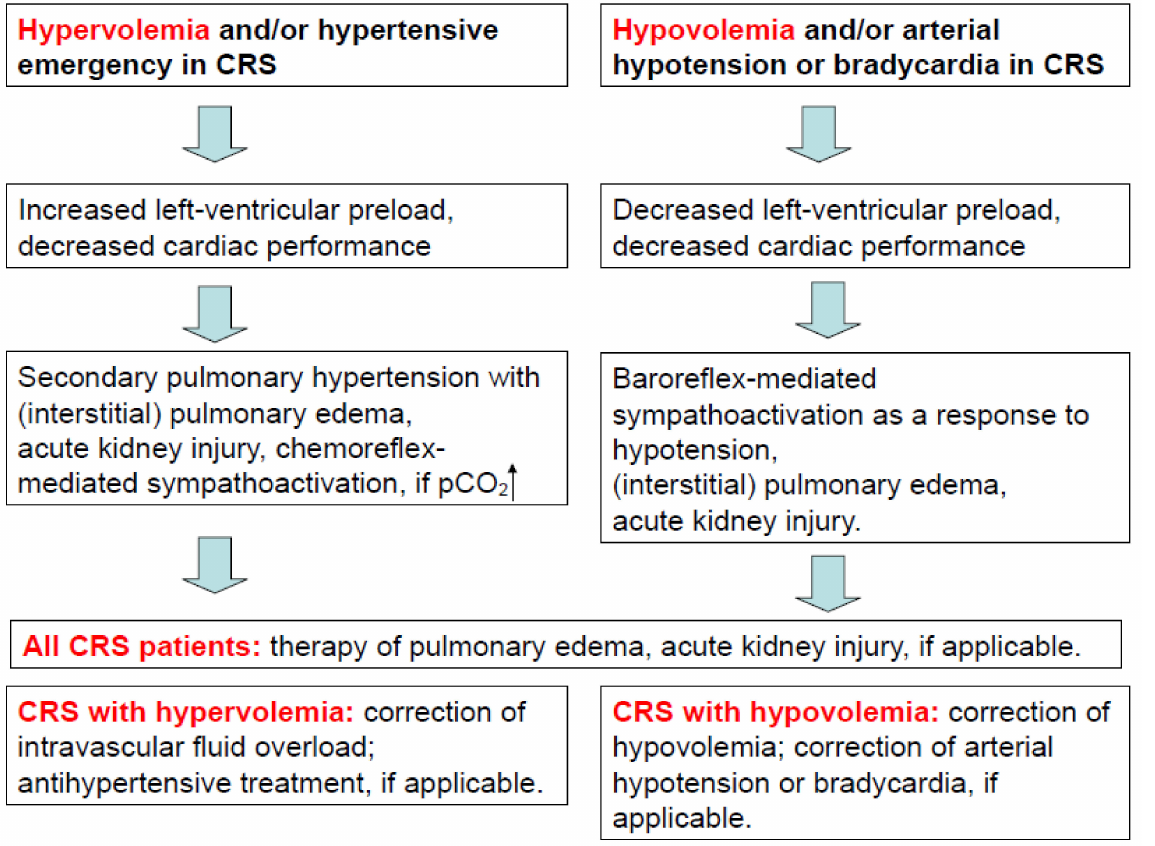
Figure 2. Title: Hypervolemia- and hypovolemia-related pathomechanisms in cardiorenal syn- drome. Legend: Cardiovascular and autonomic-nervous-system-related and pathomechanisms in hypervolemic or hypovolemic CRS. Adapted with permission from reference [16]. (Copyright 2018: Linhart et al. ESC Heart Failure published by John Wiley & Sons Ltd on behalf of the European Society of Cardiology, Creative Commons Attribution-NonCommercial